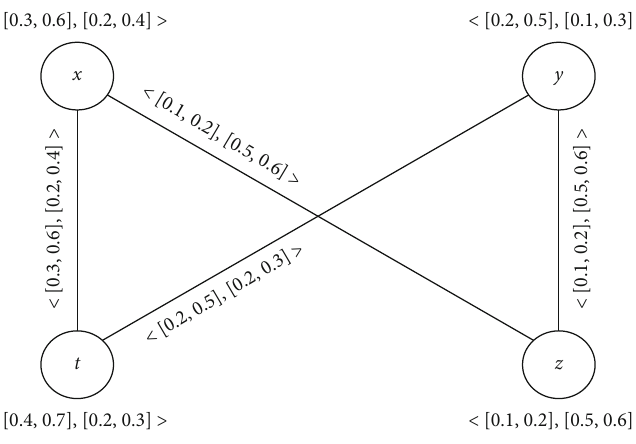
Figure 5: An IVIFG G for perfect strong matching (PSM).